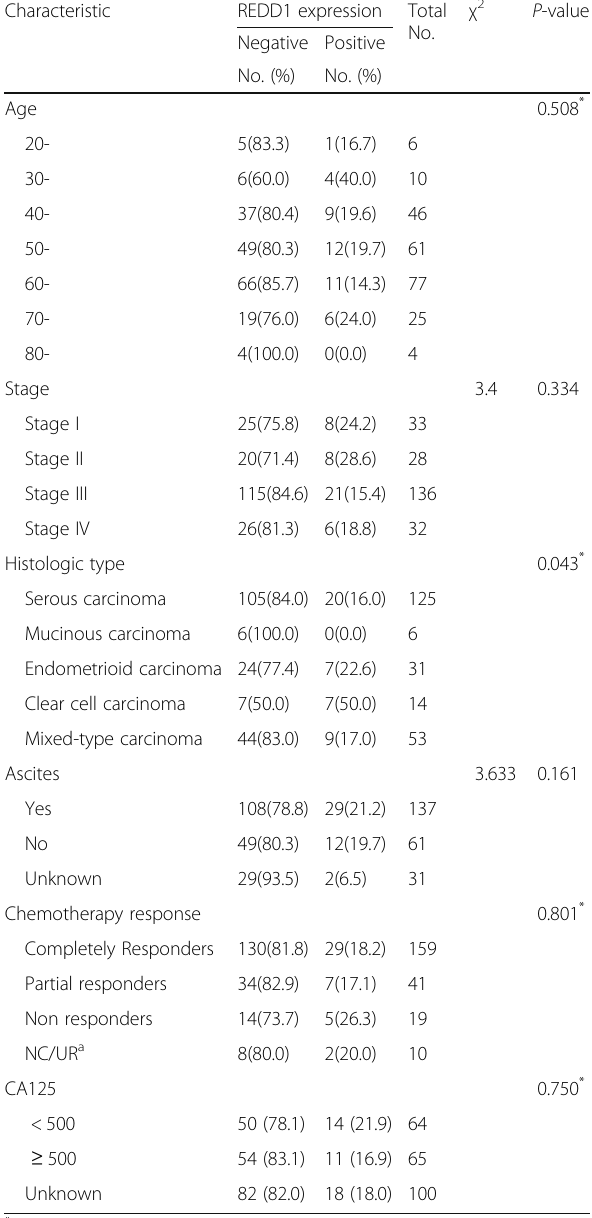
Table 3 Correlation between nuclear REDD1 expression and clinicopathologic factor Characteristic REDD1